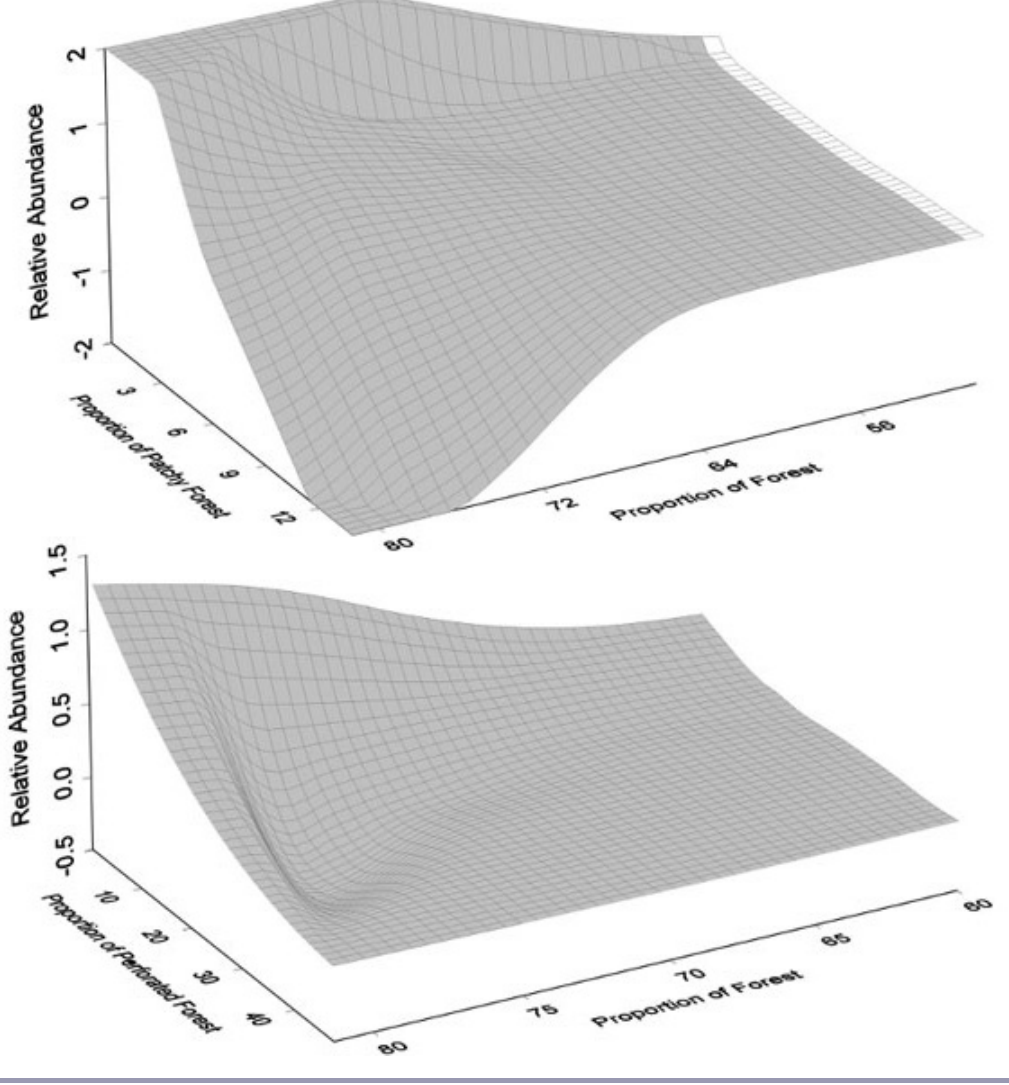
Fig. 4. The interaction of forest cover and two measures of edge forest conditions (patchy and perforated forest) indicate Golden-winged Warblers ( Vermivora chrysoptera ) increase in abundance as the proportion of forest increases and the amount of edge forest